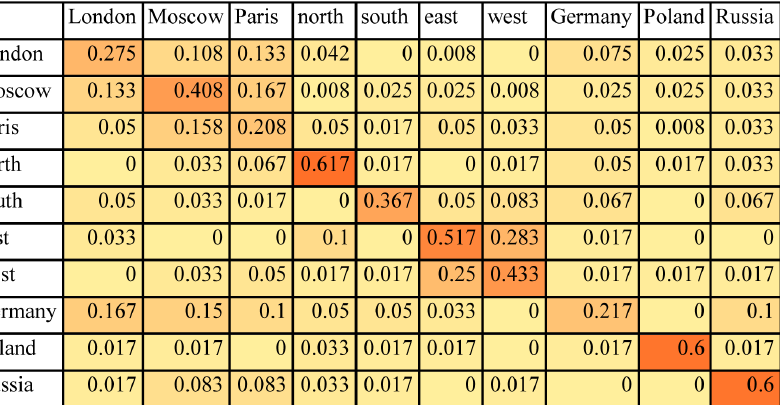
Figure 1. Conditional probability density estimates (shown as a heat map) computed from the confusion matrix resulting from the classification of 640 brain wave samples from S18 for the set of words { London,Moscow,Paris,north,south,east,west,Germany, Poland,Russia }. This table was taken from [12].